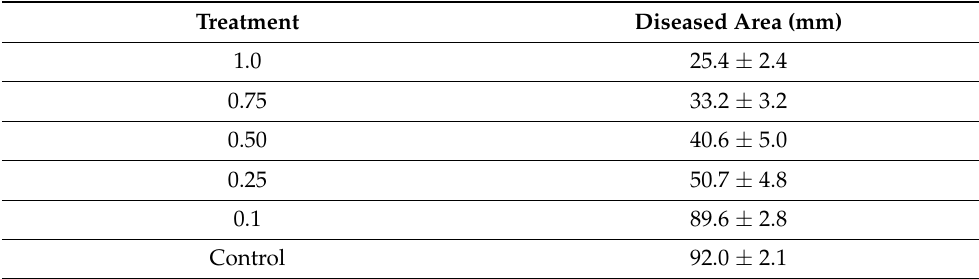
Table 4. After treatment of different concentrations of ZnO NPs on diseased lychee fruit, the disease area is shown